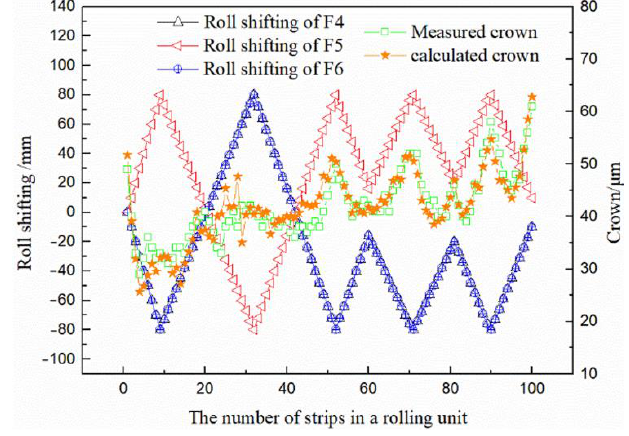
Figure 6. The measured rolling force of each stand.